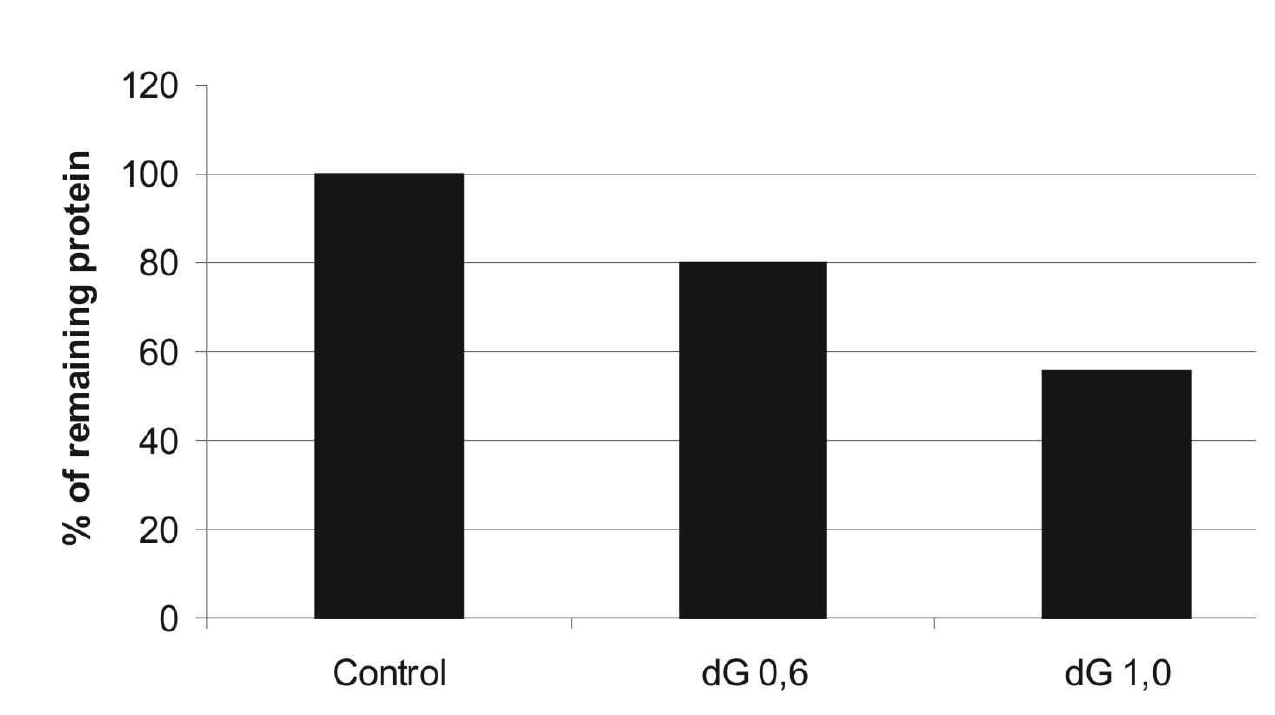
Figure S2. Gibbs free energy ( ∆ G) values clearly correlate with silencing efficiencies. As a practical example of such correlation, two small interfering RNAs (siRNAs) directed against the MeCP2 gene were identified in our laboratory using the Strand Analysis (SA) program and evaluated in vivo in mice using a hydrodynamic transfection protocol*. Western blot followed by densiometric analysis of the gel clearly confirmed that the greater the ∆ G value, the more efficient was the siRNA (below). As a negative control, mice were injected with phosphate buffered saline (PBS) only. *McCaffrey AP et al . (2002) RNA interference in adult mice. Nature.